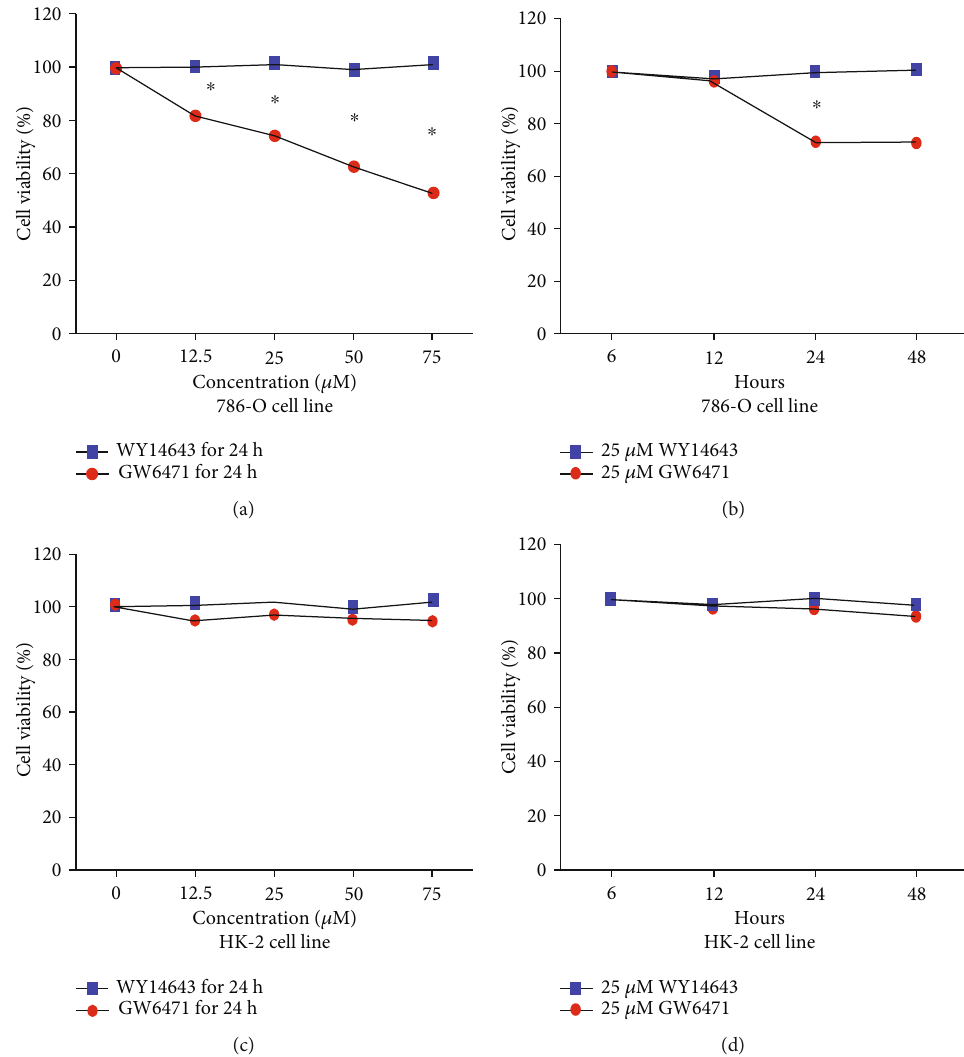
Figure 2: GW6471 decreased the viability of the 786-O cells in a dose-dependent but not time-dependent manner, and GW6471 has no e ff ect of cell viability on HK-2 cells with dose-dependent or time-dependent. (a) Cell viability of 786-O cells treated with di ff erent levels of GW6471 and WY14643 (0-75 μ M) for 24h by CCK-8 assay. (b) Cell viability of 786-O cells treated with 25 μ M GW6471 or WY14643 for 0, 12, 24, and 48h by CCK-8 assay. (c) Cell viability of HK-2 cells treated with di ff erent levels of GW6471 and WY14643 (0-75 μ M) for 24h by CCK-8 assay. (d) Cell viability of HK-2 cells treated with 25 μ M GW6471 and WY14643 for 6, 12, 24, and 48h by CCK-8 assay. ( n = 3 , unpaired Student ’ s t -test ∗ P < 0 : 05